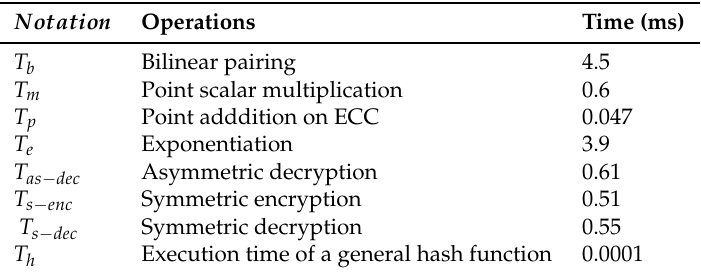
Table 1. Measurement of cryptographic operations.